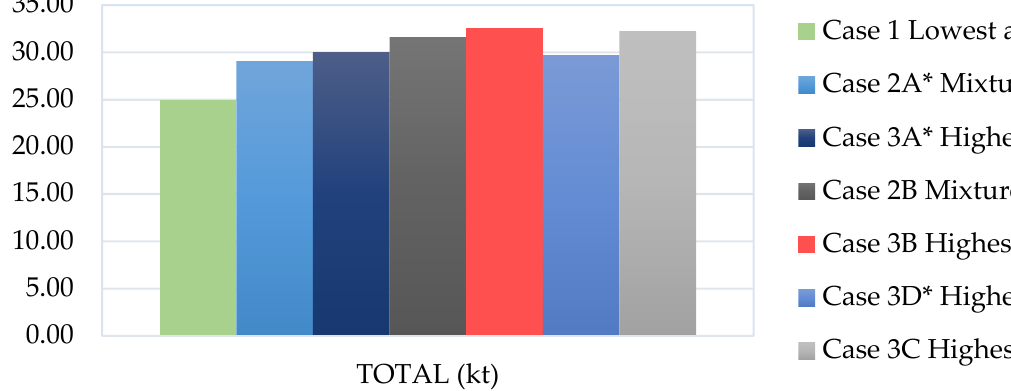
Figure 7. Total generation of CO 2e per analyzed scenario (kt of CO 2e /production lifetime). Table 36. Most centralized production compared to the most globalized scenario. CF measured in CO 2e .